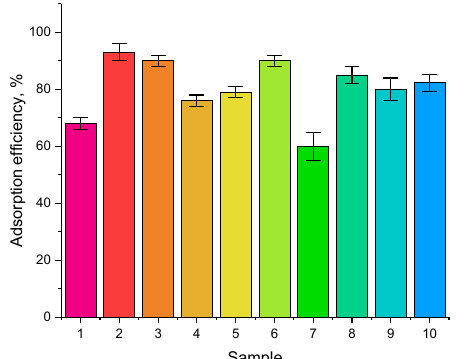
Figure 13. Comparative diagram of the adsorption efficiency of various types of nanocomposites: (1) Fe 2 O 3 [this work]; (2) Fe 2 O 3 @GdFeO 3 [this work]; (3) Fe 2 O 3 @NdFeO 3 [this work]; (4) CeFeO 3 [this work]; (5) YFeO 3 [this work]; (6) Fe 3 O 4 @LDH@MnO 2 composite [29]; (7) Magnetite nanoparti- cles [30]; (8) Co x Mn 1 − x Fe 2 O 4 nanocomposite [31]; (9) MgFe 2 O 4 nanoparticles [32]; (10) FeNi 3 /TiO 2 nanocomposite